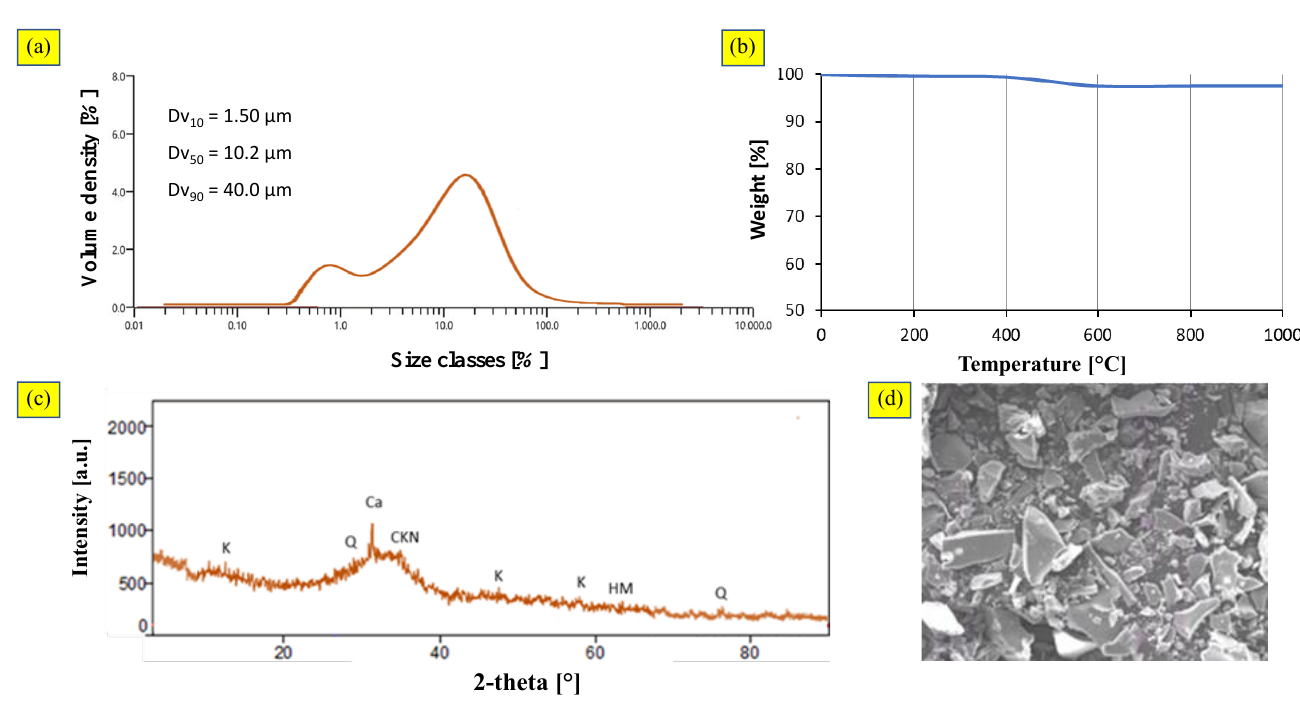
Figure 4. Blast Furnace Slag: ( a ) particle size distribution; ( b ) TGA curves; ( c ) X-ray diffraction pattern; ( d ) SEM image (scale 1000:1).